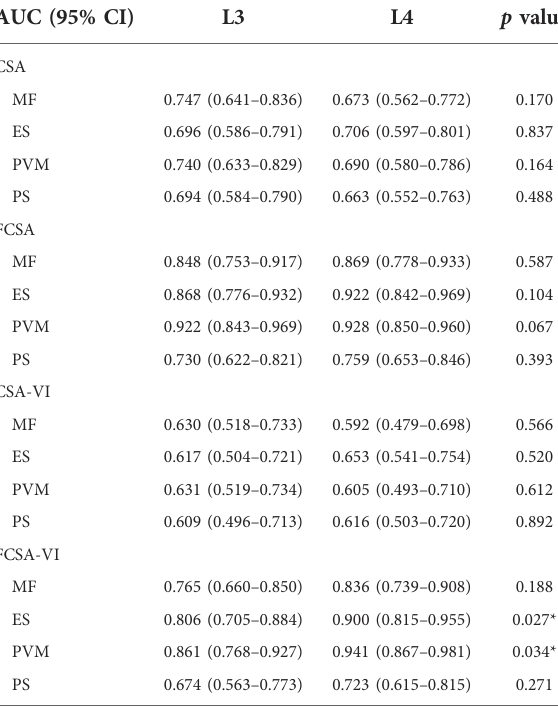
TABLE 3 Comparison of CSA-VI and FCSA-VI of each muscle between groups.